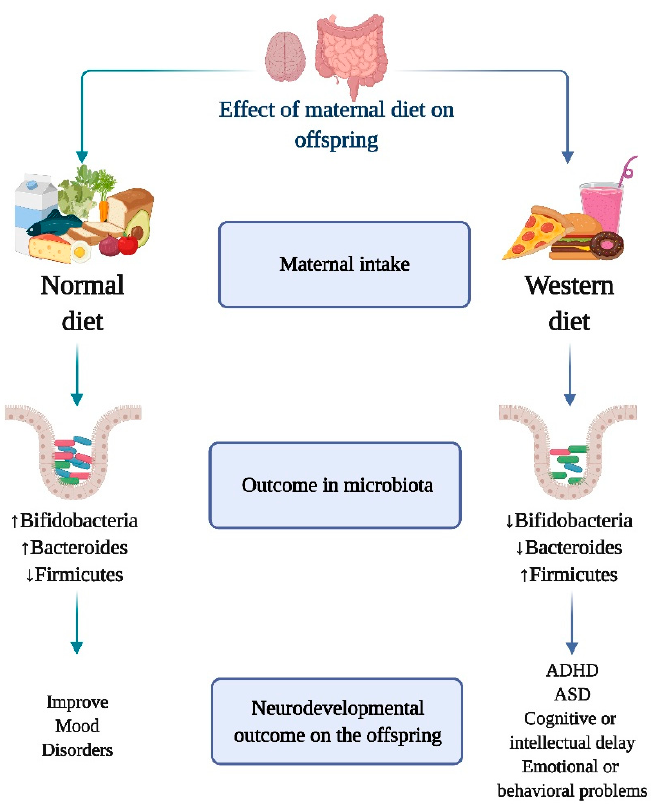
Figure 2. Role of maternal diet on the interaction of gut microbiota and neurodevelopmental outcome on the offspring. Increase in Bifidobacteria and Bacterioids and decrease in Firmicutes , is associated with the consumption of a healthy and nutritionally balanced maternal diet. This “healthy” dietary and microbiome profile has been linked to the prevention of neurodevelopmental problems and the onset of mental disorders. On the other hand, maternal intake of a diet rich in sugars, lipids and low in fruits and vegetables (Western diet) is associated with a decreased population of Bifidobacteria and Bacterioids increased Firmicutes species. The onset of neurodevelopmental illnesses such as attention deficit hyperactivity disorder (ADHD), autism spectrum disorder (ASD), cognitive or intellectual delay, and emotional or behavioral problems has been linked to the Western diet and its distinctive microbiome composition.